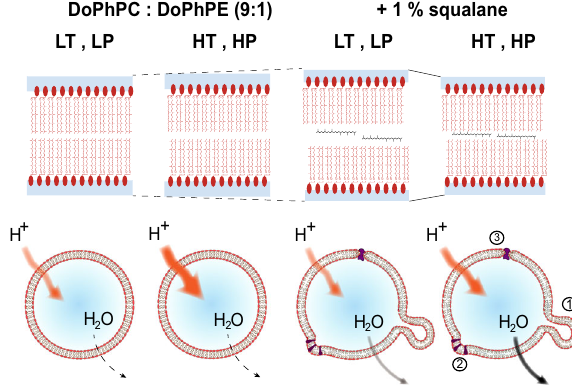
Fig. 6 Schematic view of the impact of apolar intercalant on membrane structure and function. The presence of apolar molecules renders the membrane more responsive to pressure, modulates its permeability and facilitates membrane curvature. LT: 25 °C, LP: 1 bar, HT: 85 °C, HP: 1000 bar. Top: effects of temperature, pressure, and squalane on the lipid bilayer. In the absence of squalane, a slight increase in lamellar repeat spacing is observed, which is due to the volume expansion. At LT and LP in the presence of squalane, the lamellar repeat spacing increases due to an increase in the hydrophobic region of the lipid bilayer. The membrane containing 1 mol% squalane is rather compressible, leading to a decrease in the d-spacing. Bottom: representation of the permeability of the lipid bilayer in the absence and presence of 1 mol% squalane at two extreme conditions: 25°C (LT), 1 bar (LP) and 85 °C (HT), 1000 bar (HP). In the absence of squalane, the lipid bilayer membrane is slightly impermeable to water ef fl ux. However, its proton permeability is high and increases considerably at high temperatures. When 1 mol% squalane is added, the lipid vesicles display a higher permeability towards water ef fl ux, similar to that of typical bacterial lipids. However, its proton in fl ux is lower. Furthermore, the presence of squalane induces bending membrane modi fi cations that allow the cell membrane to adopt essential curvatures for different cell functions, such as the formation of vesicles (1), insertion of membrane proteins that need speci fi c curvature (2), and transmembrane proteins anchored in lipid bilayers